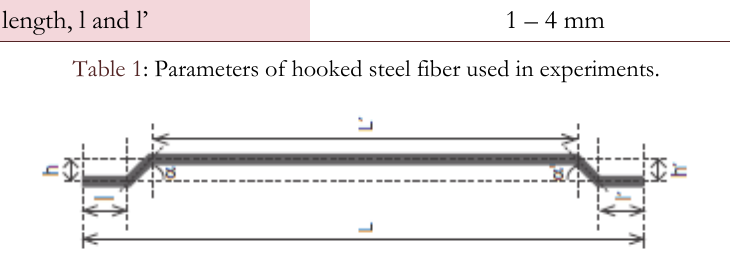
Figure 4: Geometry of steel fiber HE 75/50 used in